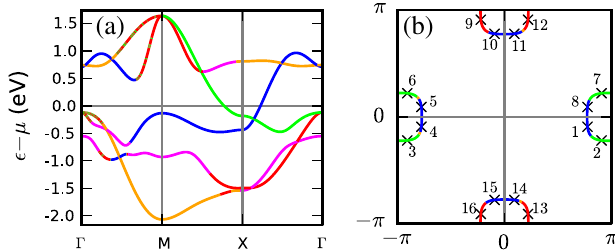
FIG. 7. The spectrum (a) and the Fermi surfaces (b) of the band structure proposed by Maier et al. [44], colored according ); to the dominant orbital content. The color code is red, ( d xz ); blue, ( d ); orange, ( d ); and magenta, ( d ). green, ( d yz xy x 2 (cid:1) y 2 3 z 2 (cid:1) r 2 The numbered crosses in (b) show the center of Fermi surface patches used in the FRG calculations.